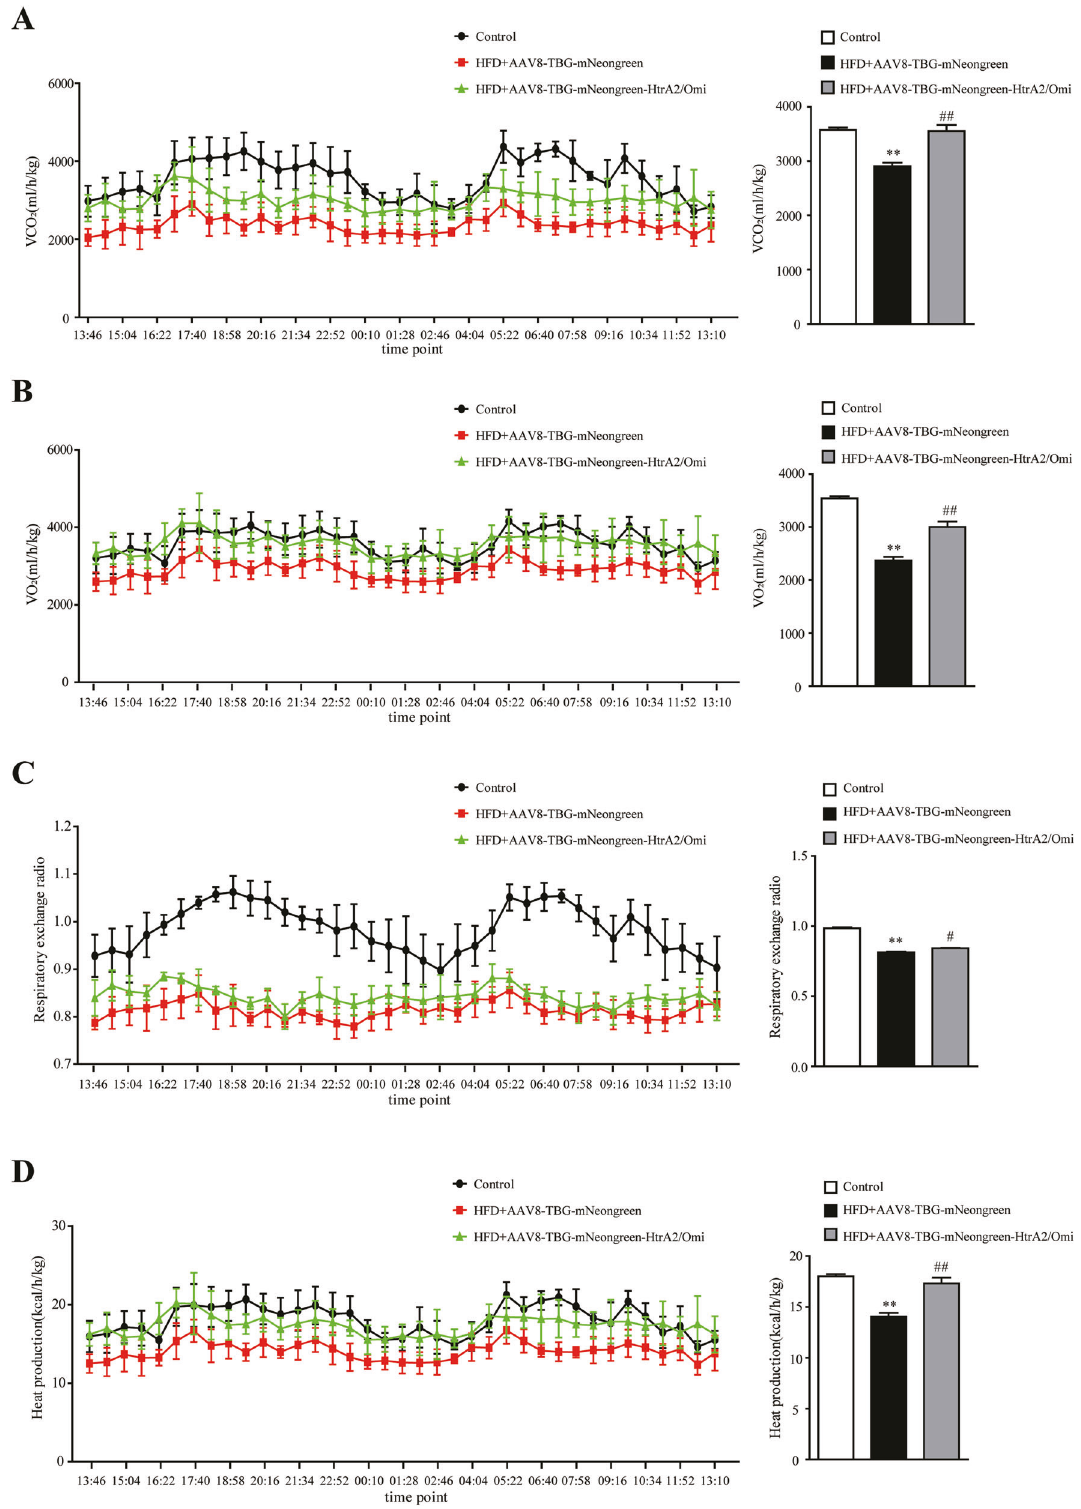
Fig. 4 Indirect calorimetry analysis showing hepatic HtrA2/Omi enhances respiratory exchange ratio (RER) and heat production in NAFLD mice. A The CO 2 production (VCO 2 ) during 12-h dark/12-h light cycles measured in a metabolic cage (left) and the average VCO 2 values were calculated (right) ( n = 6). B The oxygen consumption (VO 2 ) during two 12-h dark/12-h light cycles measured in a metabolic cage (left) and the average VO 2 values were calculated ( n = 6). C The RER measured in a metabolic cage (left) and the average RER (right) was calculated ( n = 6). D The heat production measured in a metabolic cage (left) and the average values (right) was calculated ( n = 6). Data are shown as means ± SEM. One-way ANOVA was used. * P < 0.05 vs. control group; ** P < 0.01 vs. control group; ## P < 0.01 vs. HFD + AAV8-TBG-mNeongreen group.